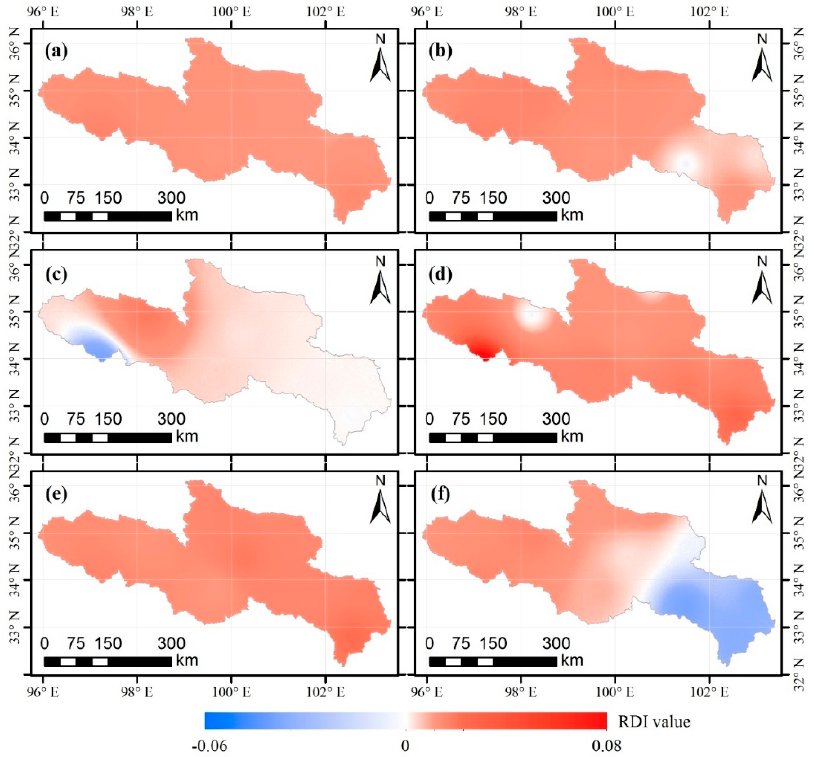
Figure 3. The geographical distribution of the mean RDI in 1961–2015 over SRYRB on the ( a ) annual, ( b ) vegetation growing seasonal (VGS) and ( c – f ) seasonal scale: ( c ) autumn, ( d ) winter, ( e ) spring and ( f ) summer.